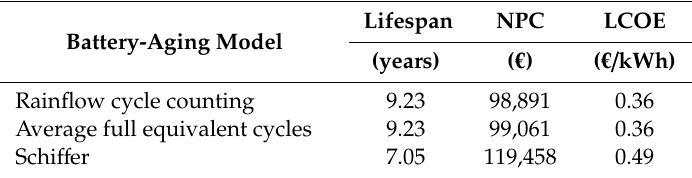
Table 10. Simulation results for the current system, using the three lead–acid battery-aging models and an average ambient temperature of 27 ◦